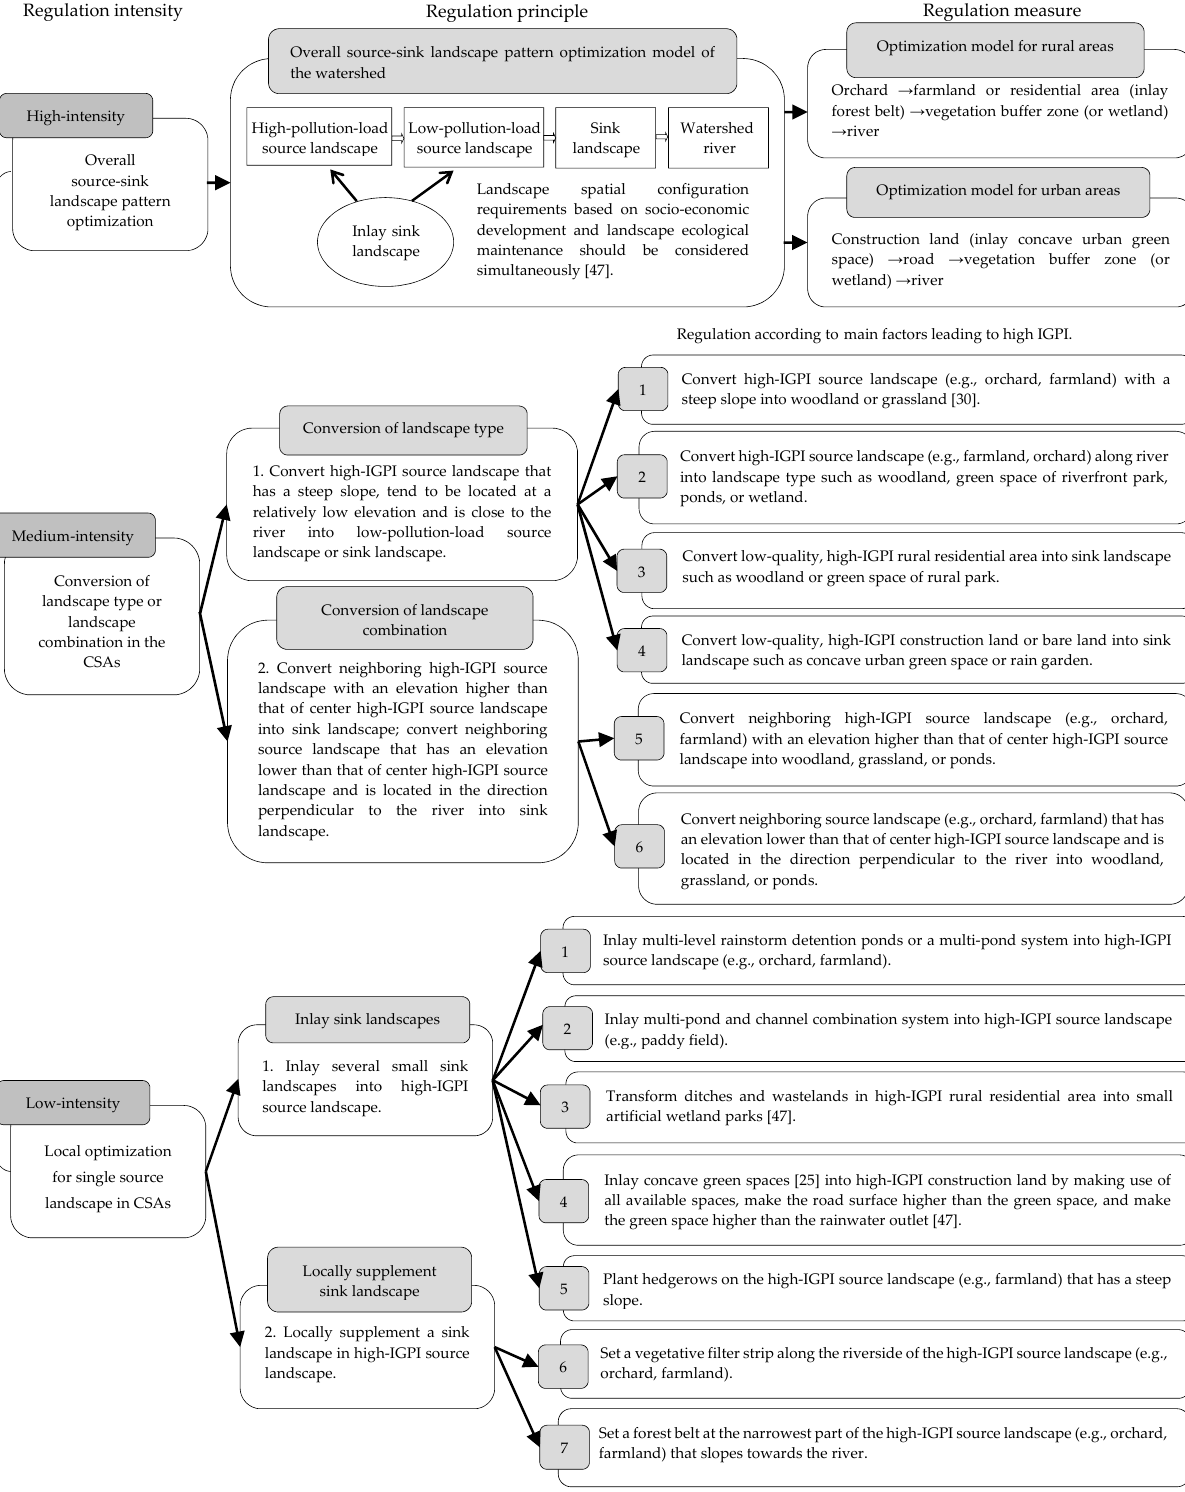
Figure 1. The comprehensive regulation system of CSAs of NPS pollution in watershed based on source-sink theory.